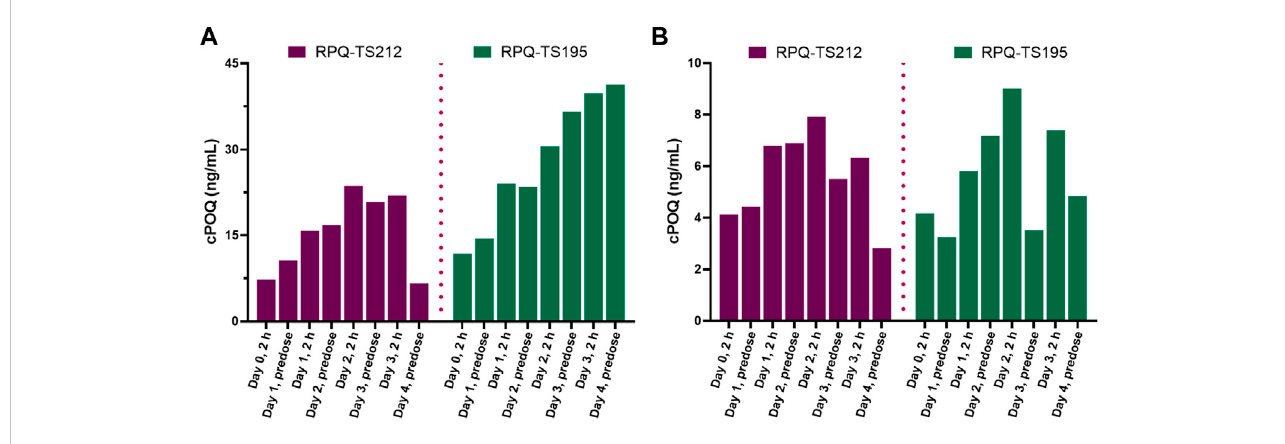
FIGURE 7 ConcentrationsofthecPQmetabolitecPOQinplasma (A) andRBCs (B) ofG6PDdsubjectsduringdailyoraladministrationoftheindividualenantiomers of